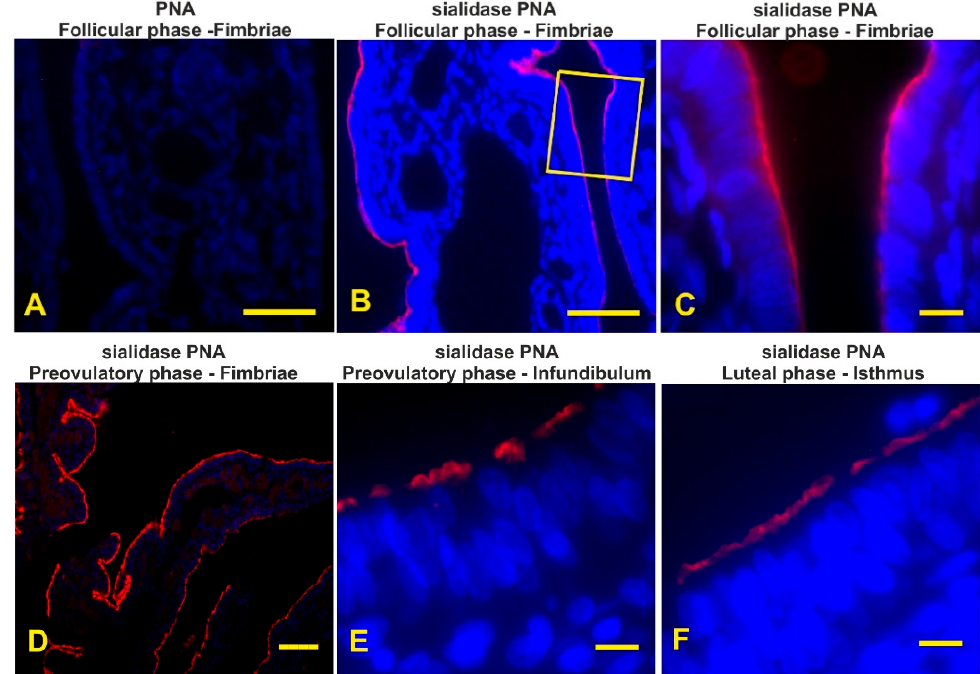
Figure 12. Localization of terminal and sialic acid penultimate Gal β 1,3GalNAc by means of PNA ( A ) and sPNA ( B – F ) in the baboon Papio hamadryas oviductal epithelium during the menstrual cycle. ( A ) Incubation with PNA alone gave negative staining. ( B ) KOH-sialidase pretreatment revealed PNA binding sites on the luminal surface. ( C ) Detail of the squared zone in ( B ). ( D ) sPNA staining of fimbriae from preovulatory baboon. ( E ) Detail of sPNA staining in the preovulatory infundibulum. ( F ) sPNA staining of the isthmus from the luteal baboon. Scale bars: ( A , B ) = 50 μ m; ( D ) = 100; ( C , E , F ) = 10 μ m.